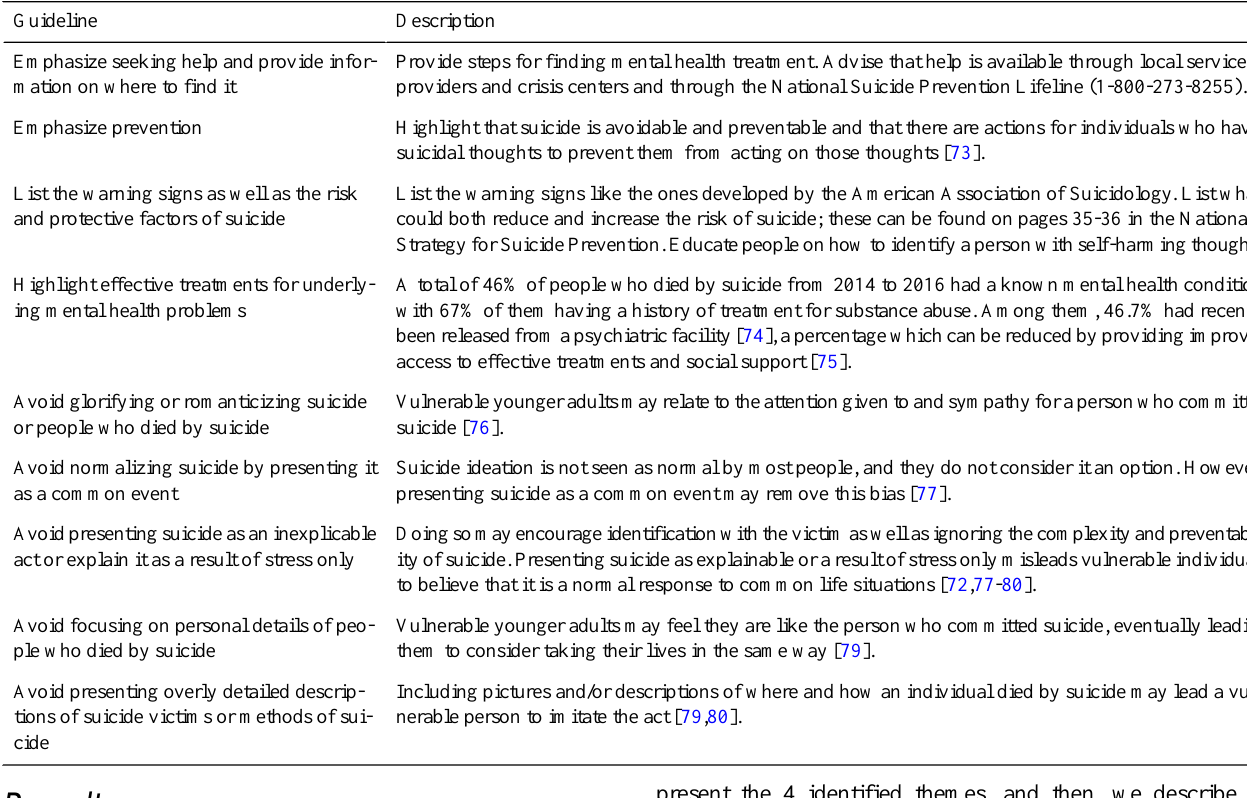
Table 2. Suicide Prevention Resource Center’s safe and effective messaging for suicide